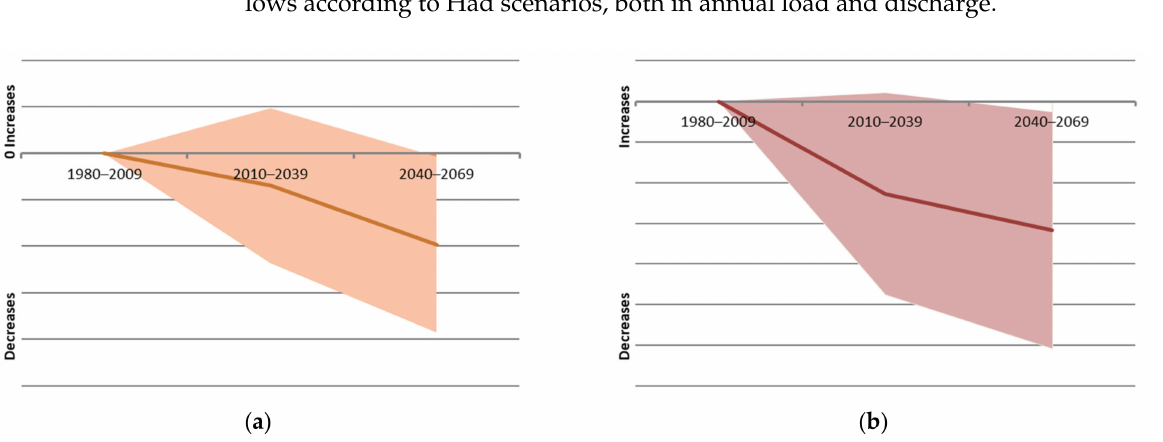
Figure 9. Direction where ( a ) environmental exposure, ( b ) societal vulnerability develop in future. Shaded area is an ensemble of different climate change scenarios.